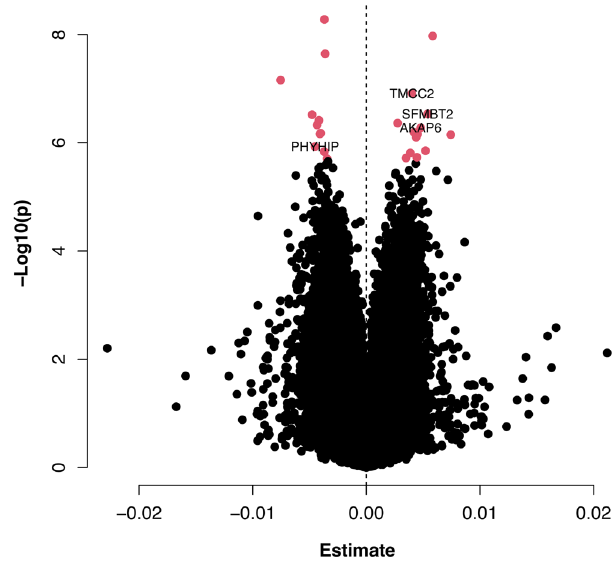
Fig. 1 | Volcano plot of discovery stage linear regression results. The fi gure shows linear regression effect estimates on the x -axis and − log(10) p -values on the y -axisforallprobesintheNBBdiscoveryanalysis( n =322biologicallyindependent samples). Red dots represent probes signi fi cantly associated when adjusting for multiple testing using the Benjamini-Hochberg false discovery rate method (two- sided FDR<0.05). The four probes replicating at two-sided p <0.05 in the BDR replication analysis ( n =200 biologically independent samples) are highlighted by closest gene